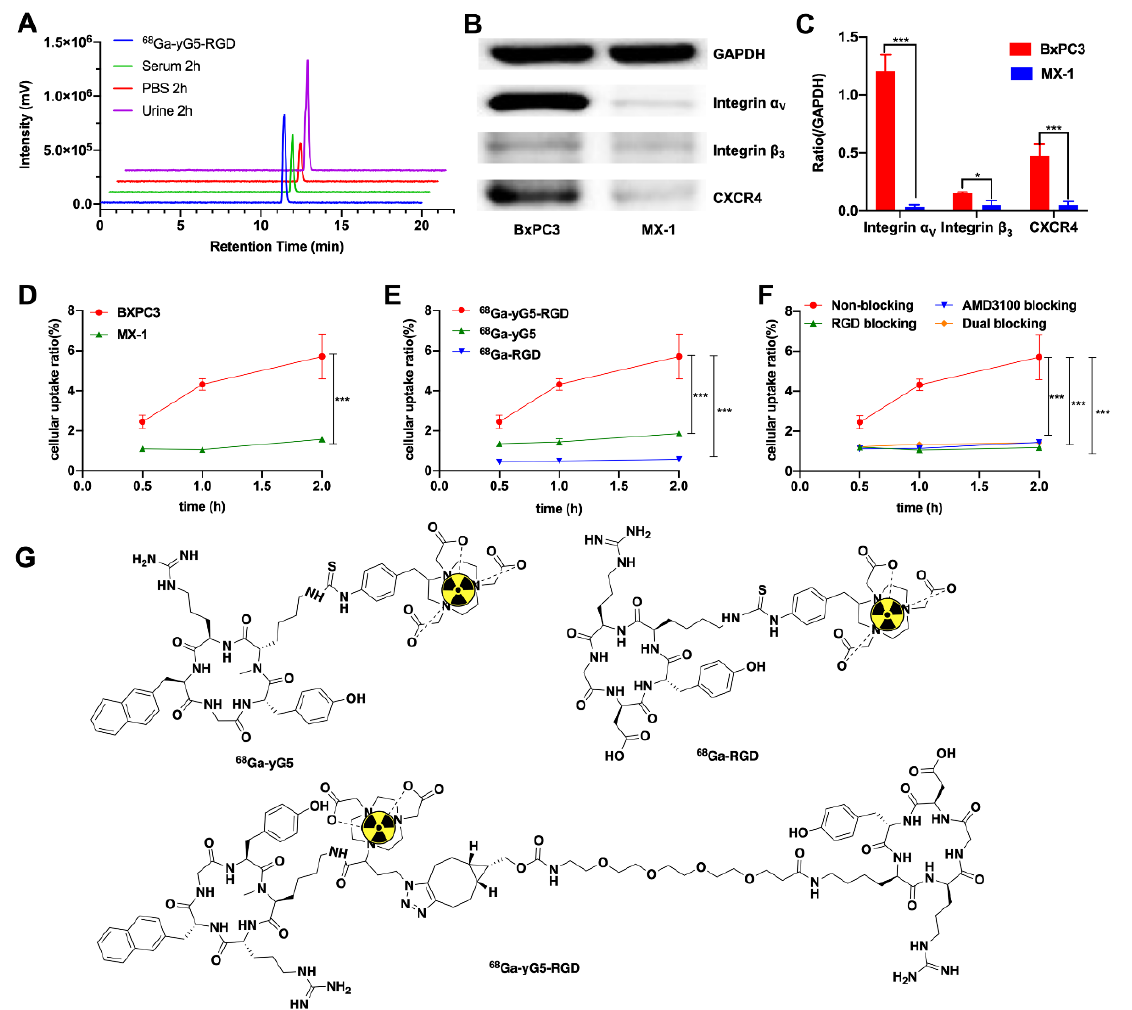
Figure 1. In vitro studies. ( A ) Identification and stability study of 68 Ga-yG5-RGD. Analytic radio- HPLC chromatograms of 68 Ga-yG5-RGD (blue). The 2 h in vitro stability of 68 Ga-yG5-RGD in PBS (red), and serum (green). The 2 h in vivo stability of 68 Ga-yG5-RGD in urine (purple). ( B ) Western blot was performed to evaluate the expression levels of CXCR4, integrin α ν , and integrin β 3 in